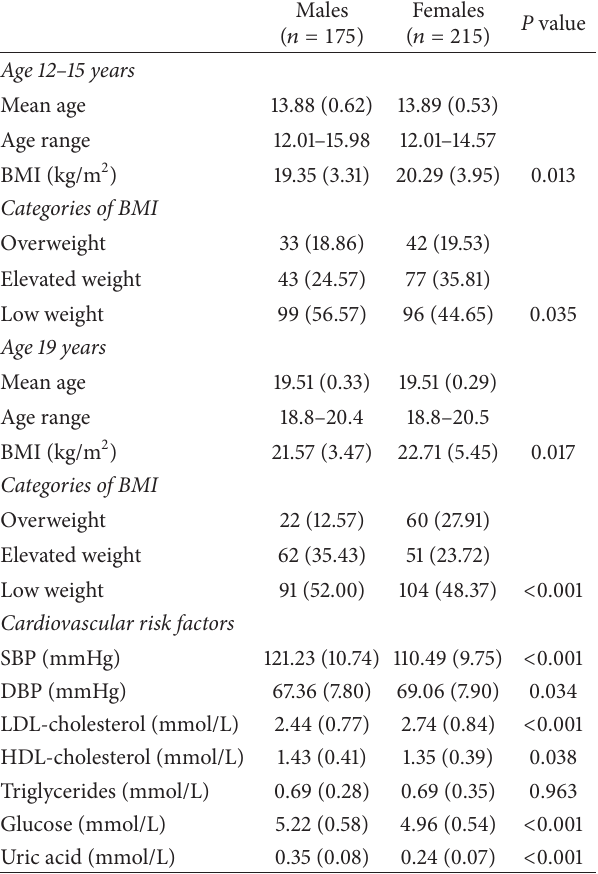
Table 1: Characteristics of the participants at the age of 12–15 years and at the age of 19-20